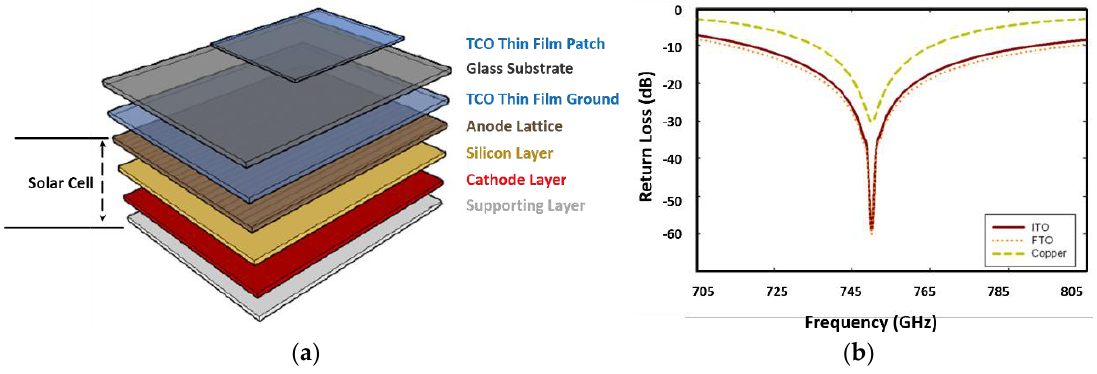
Figure 4. ( a ) Structure of designed antenna [16] and ( b ) frequency versus return loss (dB) for the antennas [17]. (With permission from Elsevier and IOP)